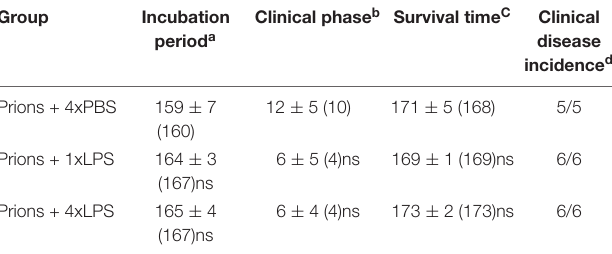
TABLE 2 | Effect of systemic LPS treatment on CNS prion